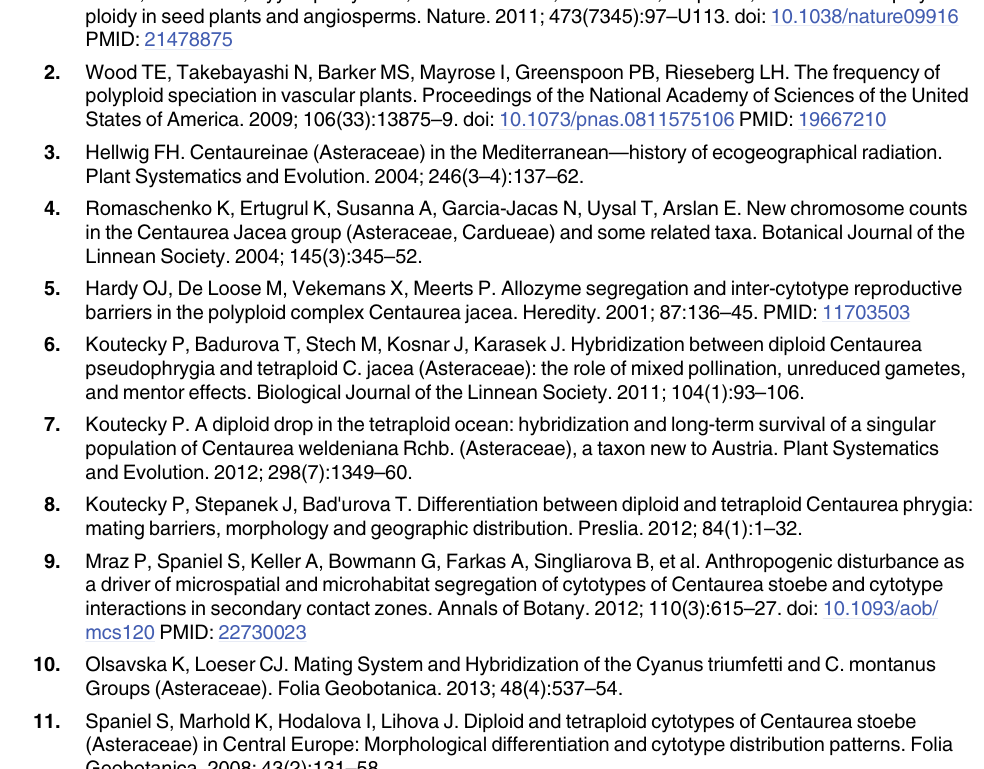
S1 Table. Repetition data: bagging date, first hand-pollination, second hand-pollination and number of cypselae for each repetition. S2 Table. Kruskal-Wallis and Dunn's tests for the number of cypselae among pollination treatments. S3 Table. Kruskal-Wallis and Dunn's tests for the number of cypselae among